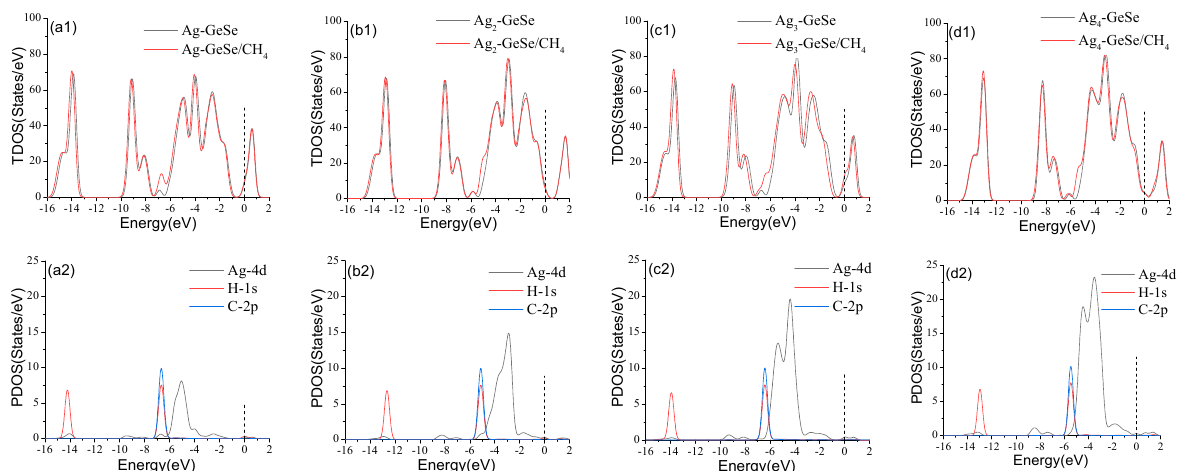
Figure 7. TDOS and PDOS of adsorption of gas molecules on Ag n − GeSe. ( a1 ) TDOS of CH 4 on Ag modified GeSe ( b1 ) TDOS of CH 4 on Ag 2 modified GeSe ( c1 ) TDOS of CH 4 on Ag 3 modified GeSe ( d1 ) TDOS of CH 4 on Ag 4 modified GeSe; ( a2 – d2 ) are PDOS of the corresponding subgraph. The adsorption parameters of CH 4 on Ag n -GeSe are listed in Table 2, including